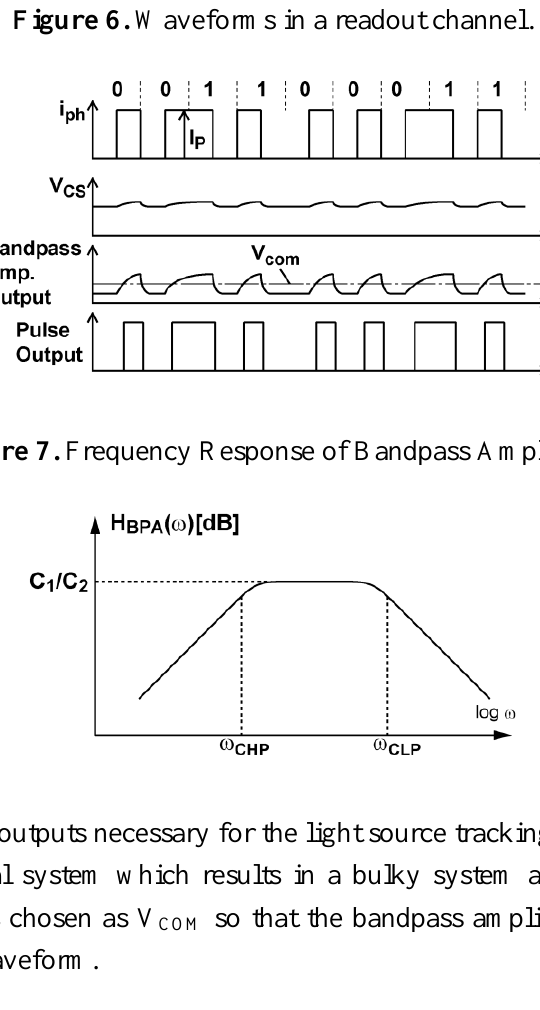
Figure 6. Waveforms in a readout channel.